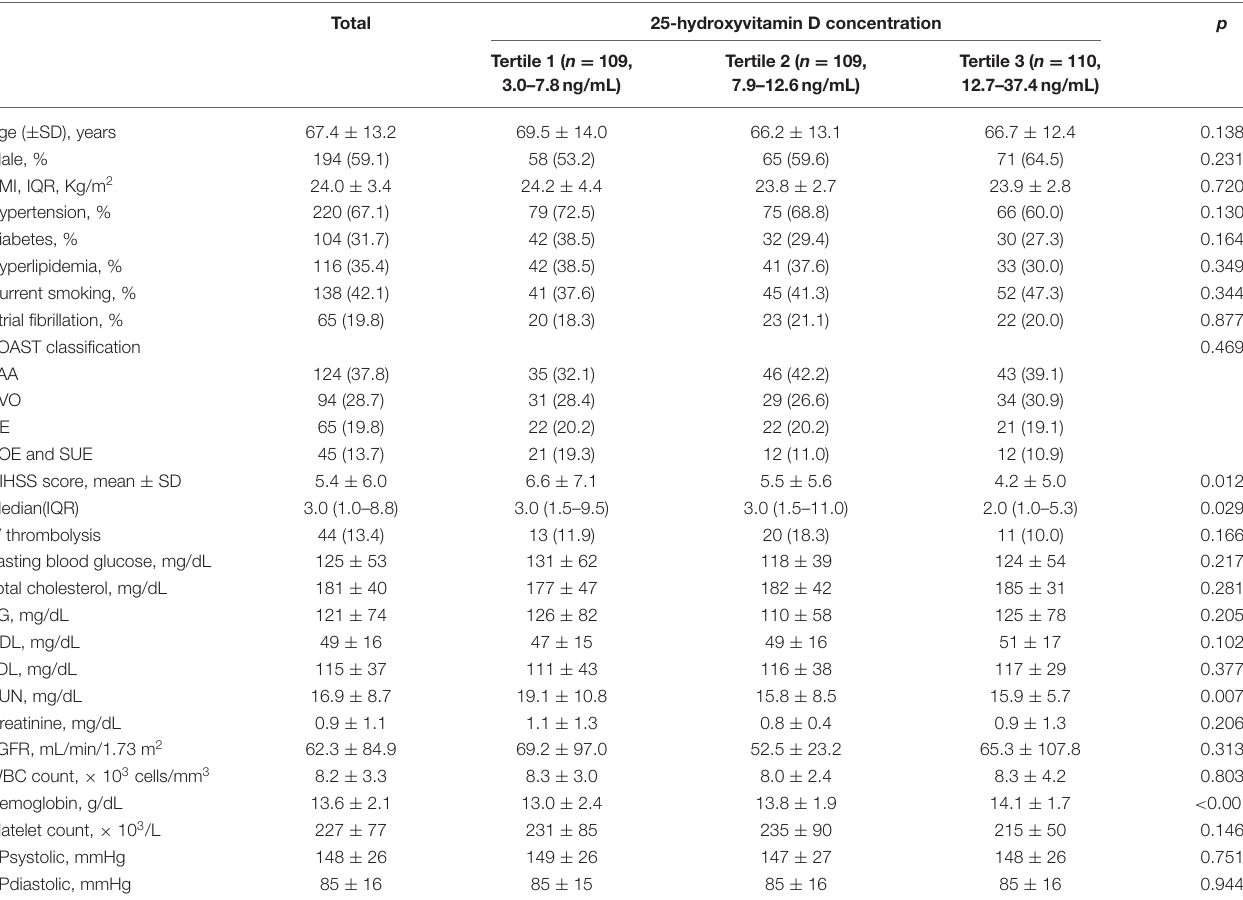
TABLE 1 | Baseline characteristic of participants according to 25-hydroxyvitamin D